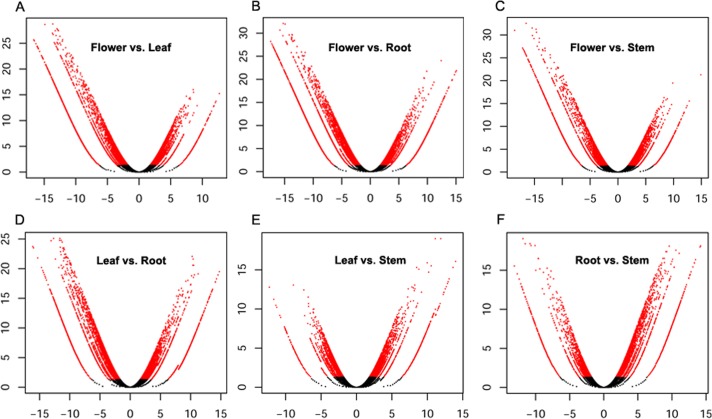
Volcano plots of differentially expressed genes based on pair-wise comparison analyzed by RNA-sequencing.The x-axis and y-axis show the fold changes on a log2 scale and the P on a –log10 scale, respectively. Genes differentially expressed with >4-fold and P<0.001 are presented in red.